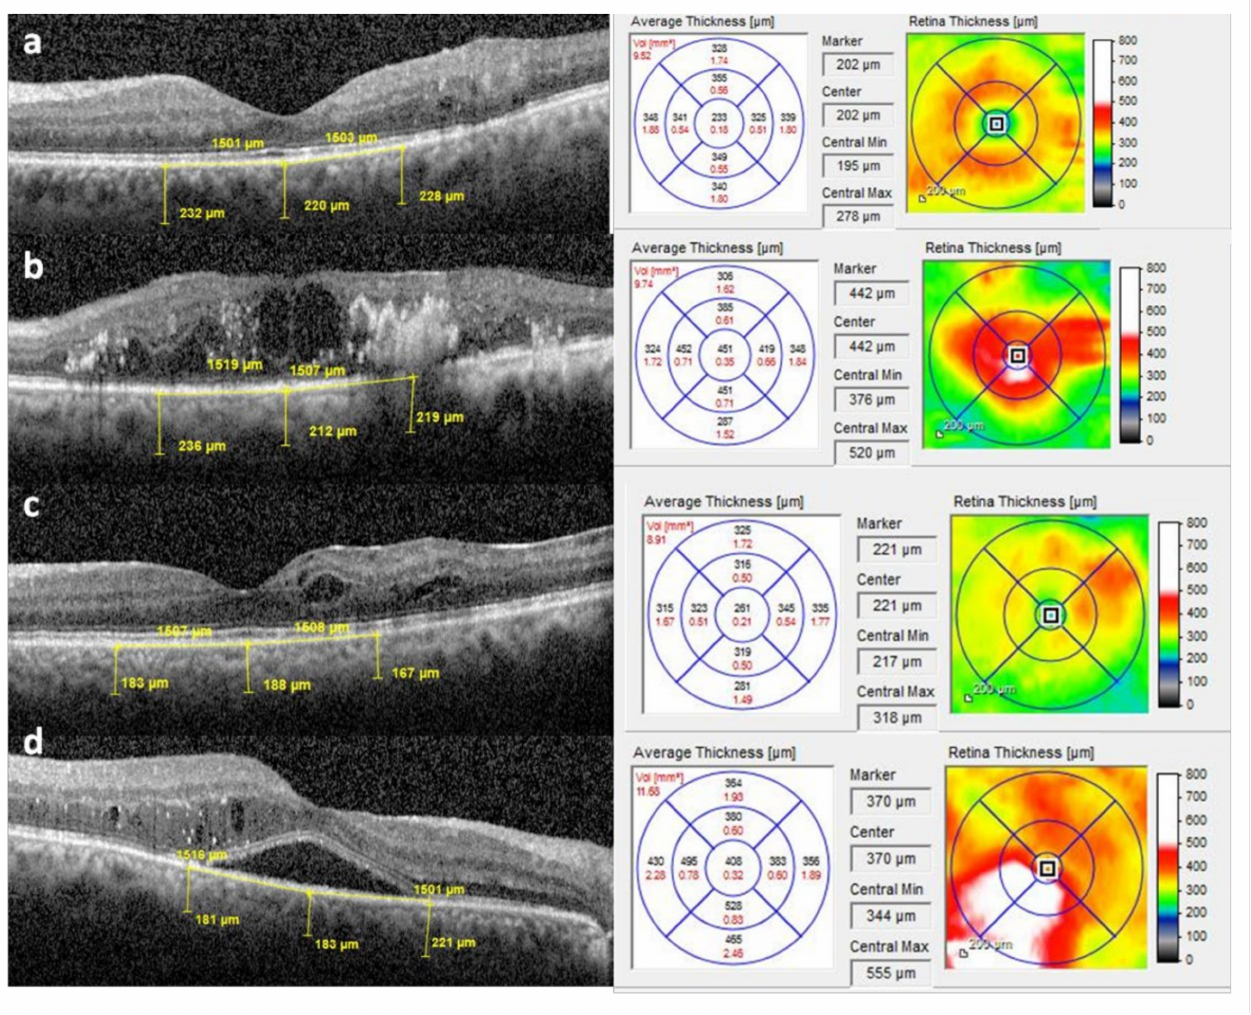
Figure 2. Measurement of choroidal thickness using calipers on a horizontal SD-OCT scan and thickness maps of ( a ) spongy macular edema (SME), ( b ) cystic macular edema (CME), ( c ) focal macular edema (FME), and ( d ) CME with subretinal fluid